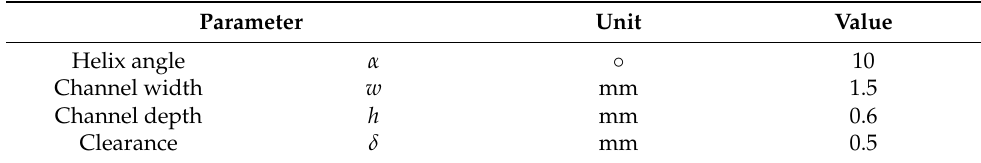
Table 2. Helical-grooved self-cooling case